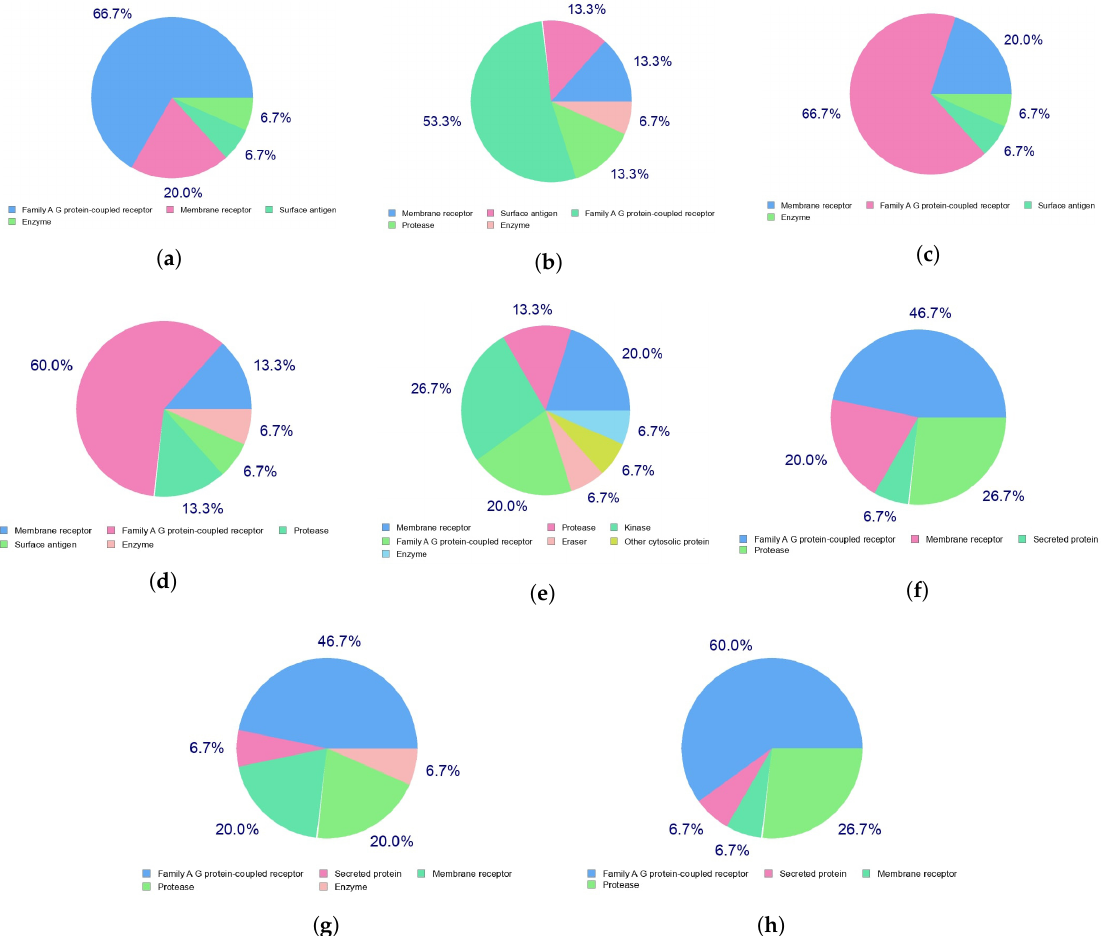
Figure 3. Predicted biological targets of the ( a ) Discodermin A, ( b ) Discodermin B, ( c ) Discodermin C, ( d ) Discodermin D, ( e ) Discodermin E, ( f ) Discodermin F, ( g ) Discodermin G and ( h ) Discodermin H